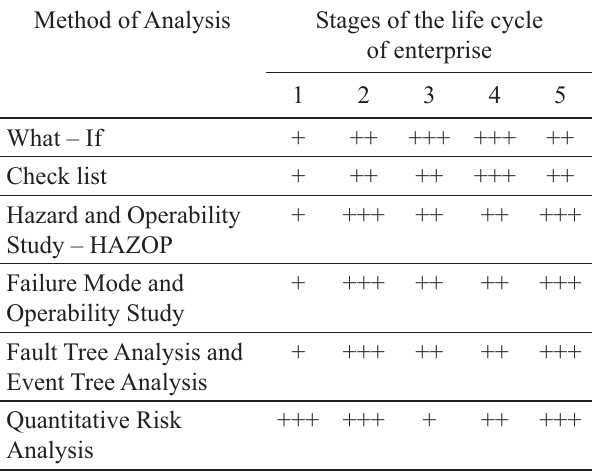
Table 2 . Recommendations on the application of methods of risk analysis at different stages of life cycle of the enterprise, having hazardous production and calculate their